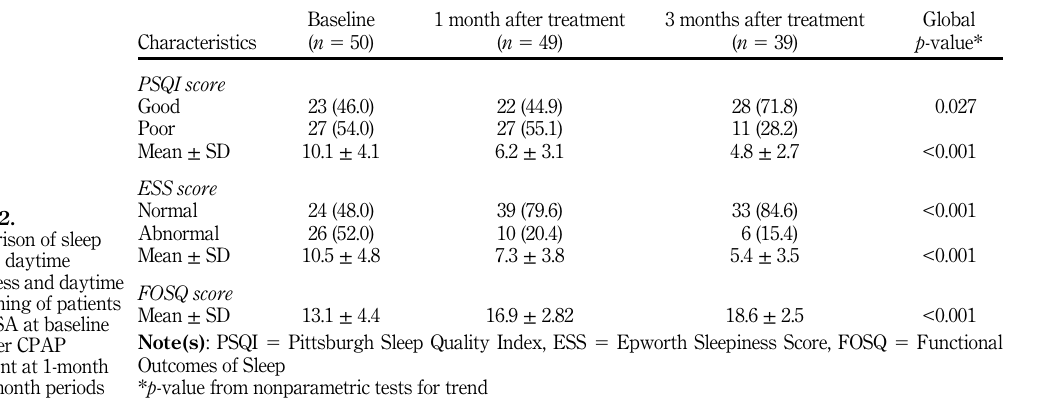
Table 2. Comparison of sleep quality, daytime sleepiness and daytime functioning of patients with OSA at baseline and after CPAP treatment at 1-month and 3-month